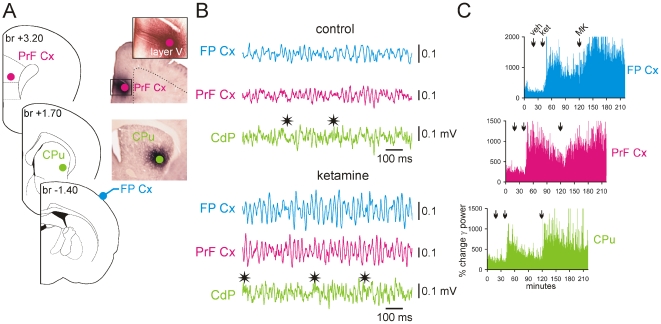
Ketamine or MK-801 increases the amount of γ oscillations in the prefrontal cortex and striatum.These triple recordings were made under fentanyl marcosis. (A): Schematic representation (modified from Paxinos and Watson, 1998) of the recording LFP sites. The stereotaxic position of each coronal plane is given in mm relative to bregma (br). The microphotographs show the location of the recording sites, which was proved following extracellular application of Neurobiotin made at the end of the recording session. The upper-right inset shows, at higher magnification, the apical dendrites of pyramidal neurons of layer V, the location of the recording site (multiunit labeling). (B): 1-s episodes of LFP (bandpass: 10–200 Hz) recorded ∼15 min after subcutaneous injection of vehicle (saline, 1 ml/kg = control) then ∼20 min after injection of ketamine (5 mg/kg). Note that systemic injection of ketamine increases the amplitude of γ oscillations in all recorded structures. High-frequency (81–160 Hz) oscillations are also increased in the striatum and prefrontal cortex (asterisks). (C): Simultaneous % changes in γ power at the three recording sites after subcutaneous injections of vehicle (veh; 1 ml/kg), ketamine (ket; 5 mg/kg) then of MK-801 (MK; 0.08 mg/kg). CPu, caudate putamen; PrF Cx, prefrontal cortex; FP Cx, frontoparietal cortex.